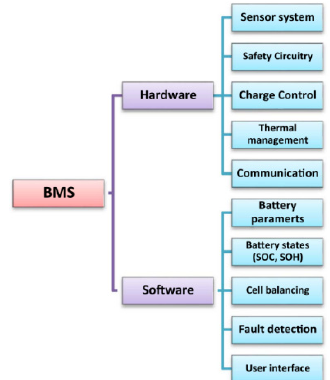
Figure 1. Basic framework of the battery management system (BMS) [17].